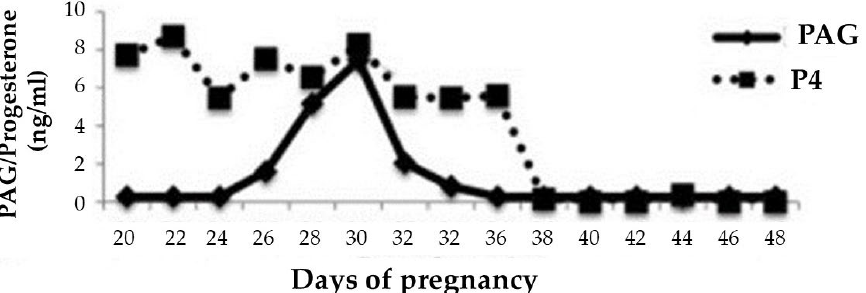
Figure 2. Pregnancy-associated glycoproteins (PAGs) and progesterone (P4) in a cow that experienced embryonic mortality between days 30 and 40 of gestation. Adapted from Pohler et al. [69].